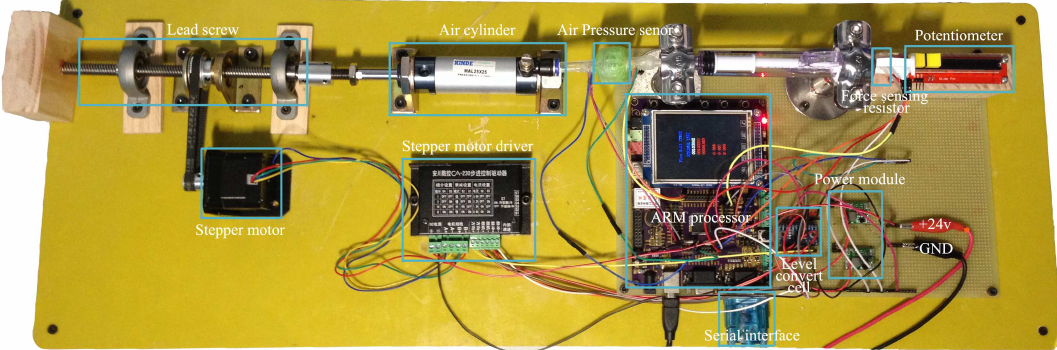
Figure 2. The proposed syringe device